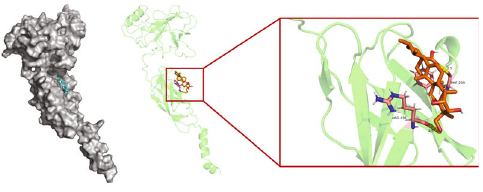
Figure 4: Asiatic acid docking with p65